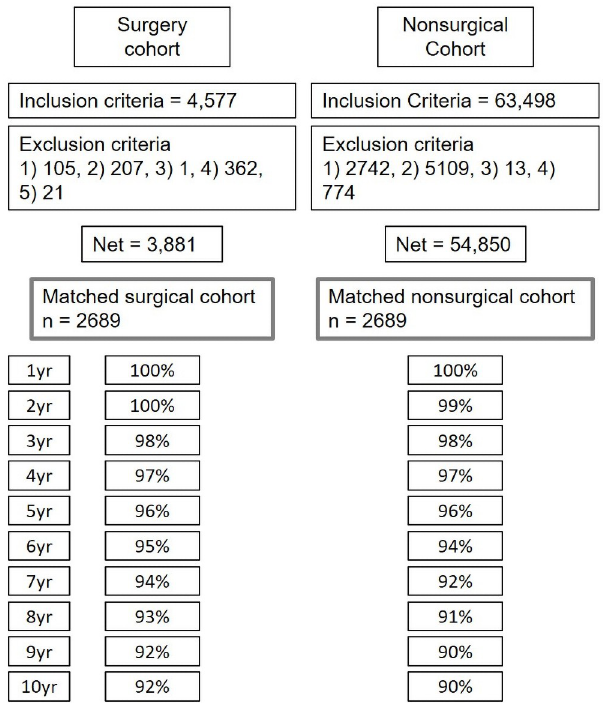
Fig 1. Flow diagram of patients. The number of patients were described in the box. The follow-up rates were marked along with time points. The detailed inclusion and exclusion criteria are described in the manuscript.